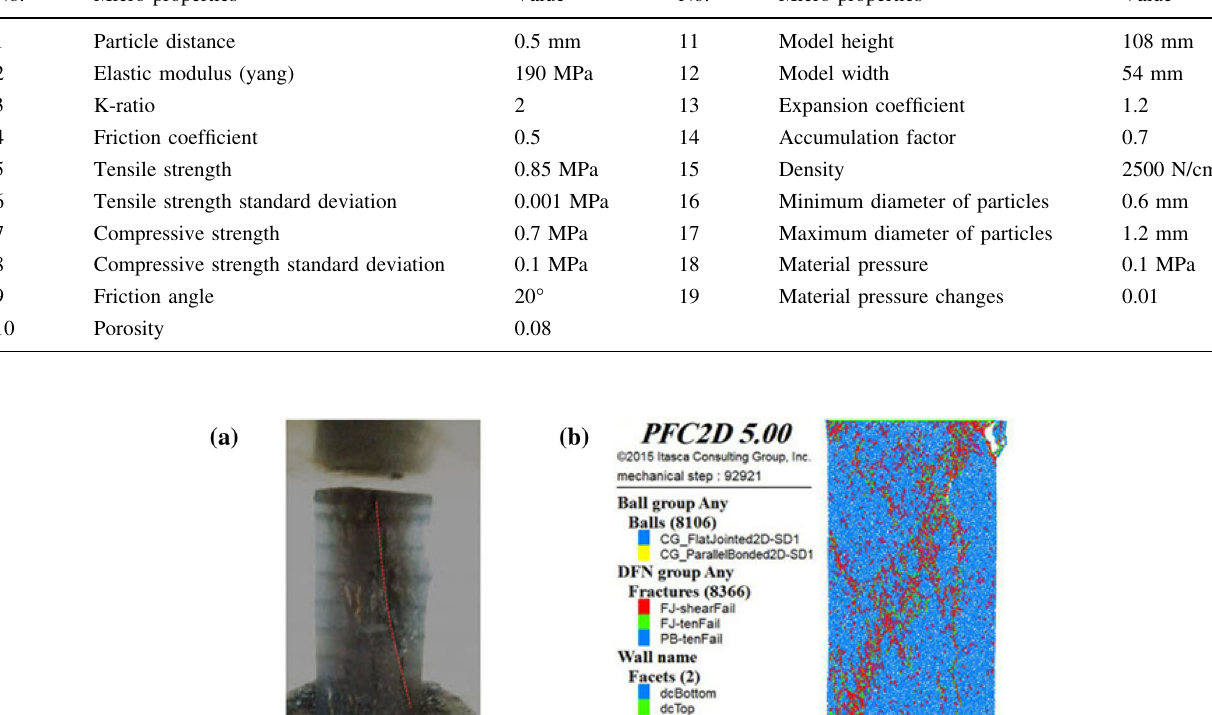
Table 2 Micro properties used for model calibration No.